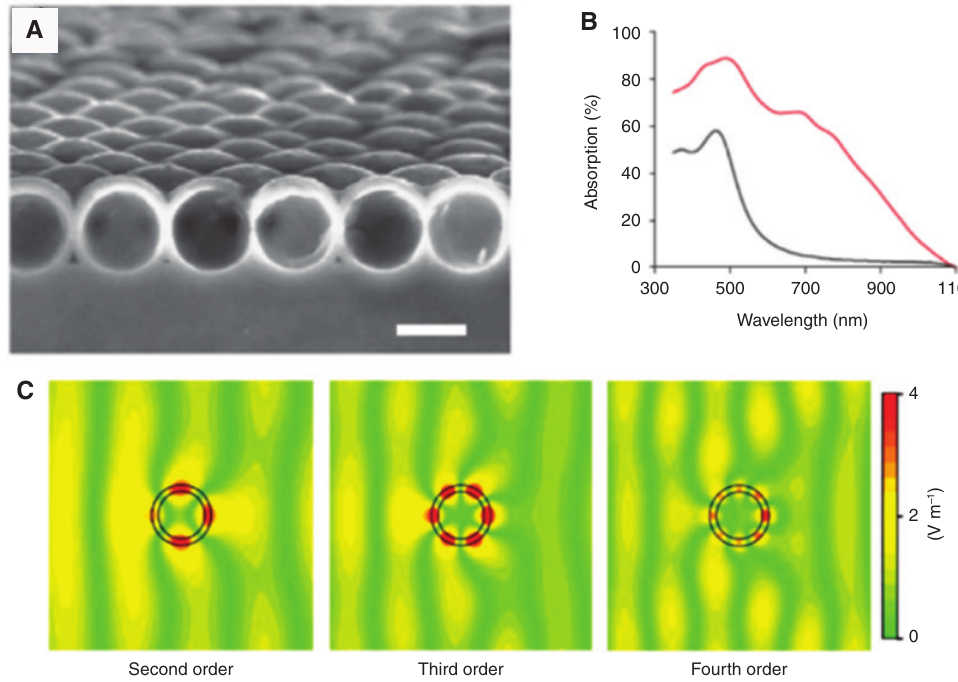
Figure 11: Light absorption enhancement based on WGMs in hollow spherical nanostructures. (A) An SEM cross-section image of a monolayer hollow spherical structure on a substrate. (B) The comparison of absorption spectra of the sample without (black line) and with (red line) hollow spherical nanostructures measured under normally incident light with an integrating sphere. (C) Calculated electric field distribution of signal hollow spherical structure with various resonant modes. Adapted with permission from ref. [35], COPYRIGHT 2012 Macmillan Publishers Limited.